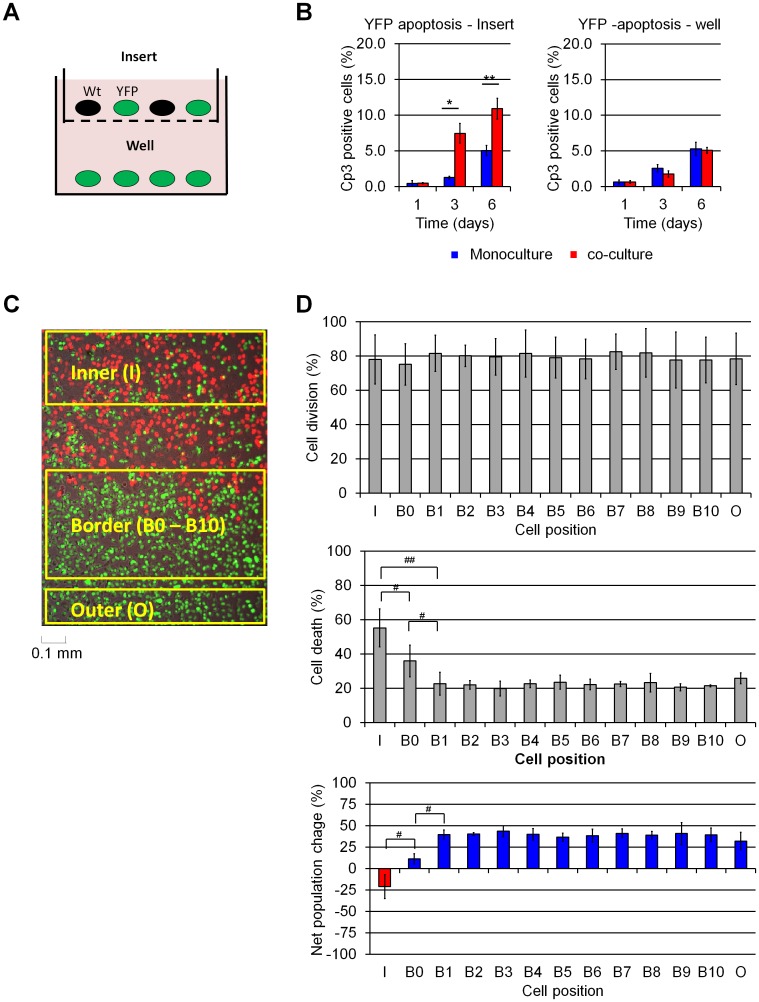
U2OS cell competition interactions are short-ranged.(A) Schematic representation of U2OS transwell cultures, Cells shared culture medium but were separated by a 0.8 μm Durapore membrane. (B) Cp3-IF analysis of apoptosis in transwell cultures. Wt cells induce apoptosis in YFP cells in the insert but not in YFP cells separated by the transwell. (C) Spot-seeding of YFP and H2B-mCherry expressing clone R1. Mixed YFP:R1 spots surrounded by pure YFP cell populations were divided in “inner” (I), “border” (B), and “outer” (O) zones as represented. (D) Time-lapse microscopy tracking of YFP cell fates during 72-hour spot cultures. The number of cell layers separating each YFP cell from its nearest R1 neighbor was recorded, and YFP “B” cells were grouped accordingly: for instance, a YFP cell is labeled “B3” if it comes within 3 cell layers of the nearest R1 cell, while a”B0” YFP cell comes to lie adjacent to an R1 cell at any time during the observation period. The data summarizes the fate of cells present at the beginning of each experiment and their immediate progeny, followed over 72 hours. The percentage of followed cells that underwent cell division is shown at the top; cell death is shown at the middle, and net population size change at the bottom. Increased apoptosis is observed only in inner YFP cells and “B0” border cells that come in direct contact with R1 cells. Data in panel D was derived from 3 independent experiments (Supplemental Movie S1-3), comprising over 5,000 cells counted. *: p<0.05, **: p<0.01 by Student’s t-test; #:p<0.05, ##:p<0.01 by paired t-test.